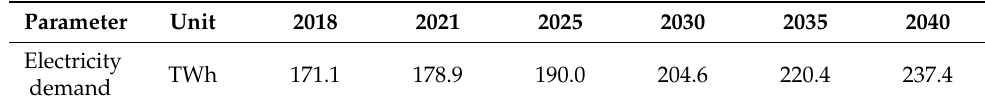
Figure 5. Power demand in the Polish power system in 2018 (based on [31]). Table 2. Electricity demand in